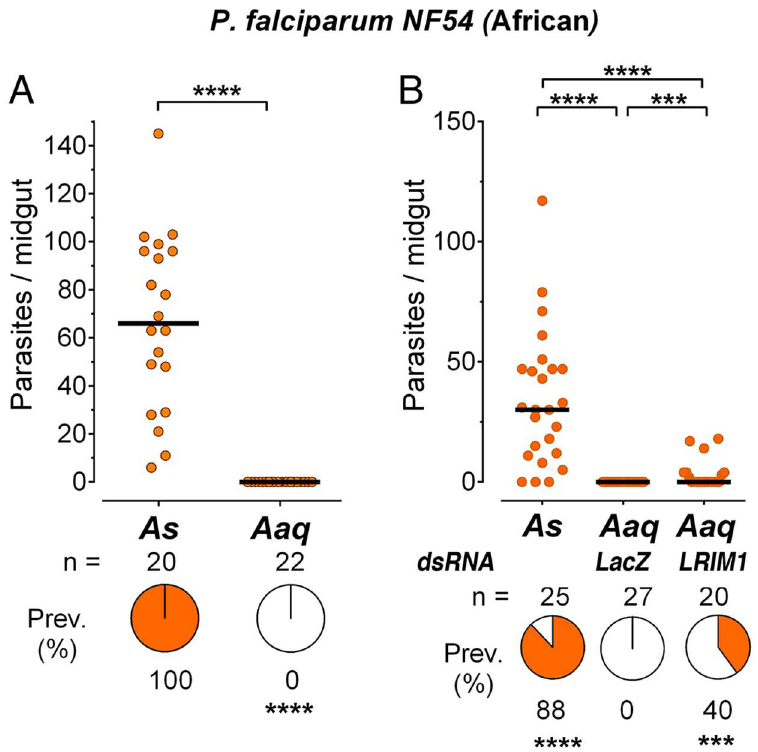
Fig 1. Infection of A . aquasalis with P . falciparum NF54. (A) Susceptibilityof Anophelesstephensi (As) and Anophelesaquasalis (Aaq) mosquitoesto infection with Plasmodium falciparum NF54 strain. (B) Effect of disrupting the mosquitoimmune system by silencingLRIM1 on Aaq susceptibilityto infection. Each dot represents the numberof oocysts present on an individualmidgut 10–12 days post-infection and the median numberof oocysts is indicatedby the black line. The medianswere comparedusing the Mann-Whitney test and the infection prevalence using Chi-square ( *** p < 0.001, **** p < 0.0001).